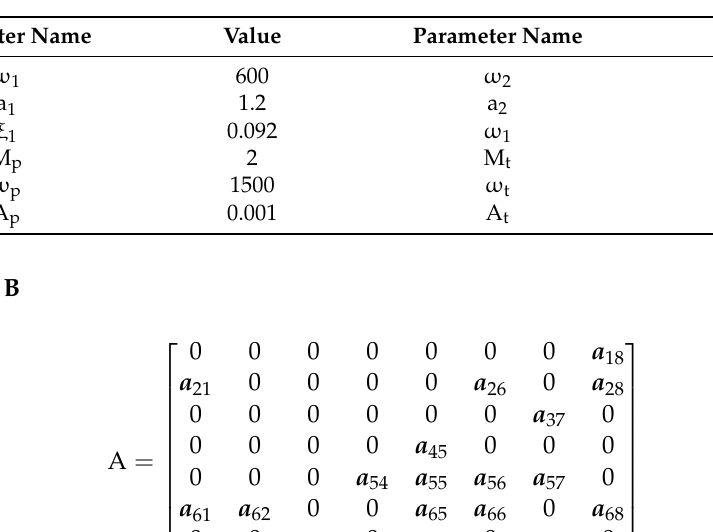
Table A2. The parameters of the weighting